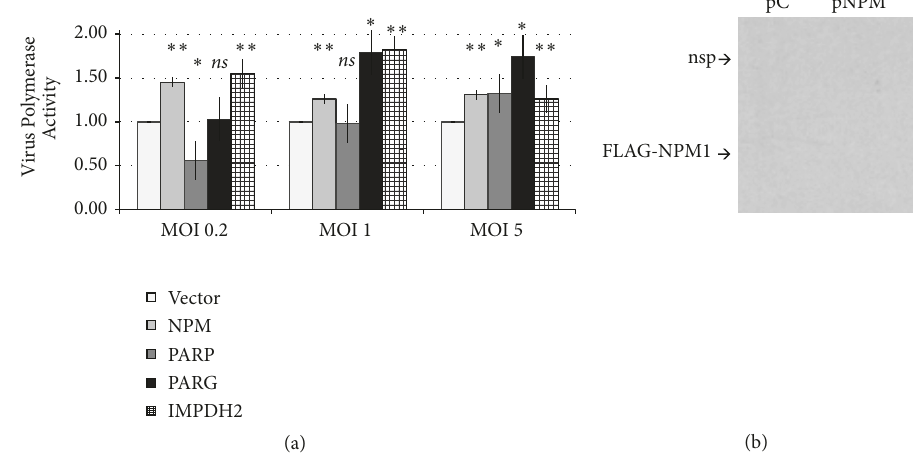
Figure 4: Expression of PARG, the endogenous enzyme counteracting PARP1/2 proteins, increases RdRP activity in influenza-infected cells. (a) HEK 293T cells were transfected with an RdRP reporter plasmid, and empty vector or cDNA expressing NPM, PARP1, PARG, or IMPDH2. After 24h, cells were infected with low-path, H5N1 HALo virus at MOI indicated, and viral polymerase activity was analyzed 20h.p.i. by luciferase reporter assay. All experiments were performed in independent biological duplicates with two readings per well (a total of four readings per condition). (b) Western blot with expression of FLAG-NPM1 plasmid; vector, pC ; for PARP1 plasmid; see Figure